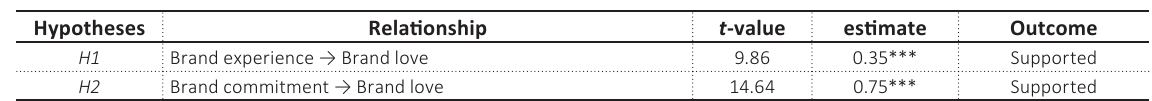
Table 5. Paths, estimates, and